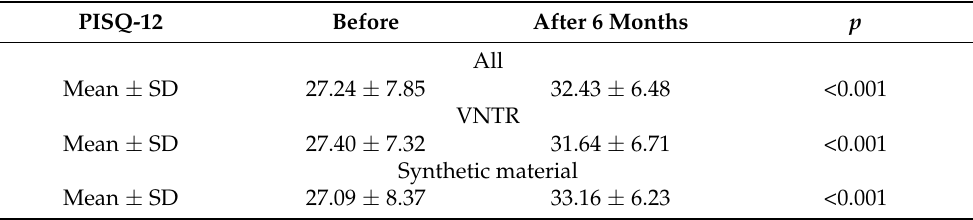
Table 3. Mean results of the female sexual function index (FSFI) questionnaire before and 6 months after surgery. FSFI Before After 6 Months p All Mean ± SD 20.09 ± 8.09 23.82 ± 6.96 <0.001 VNTR Mean ± SD 20.52 ± 8.18 23.42 ± 7.64 <0.001 Synthetic material Mean ± SD 19.7 ± 8.04 24.2 ± 6.29 <0.001